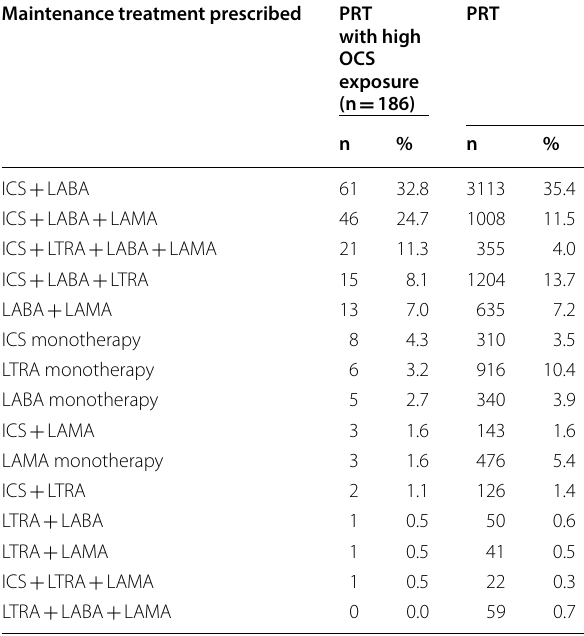
PRT persistent respiratory treatment, SABA short‑acting beta2 agonist, OCS oral corticosteroids, ICS inhaled corticosteroids, LABA long‑acting beta2 agonists, LTRA leukotriene receptors antagonists, LAMA long‑acting muscarinic antagonist